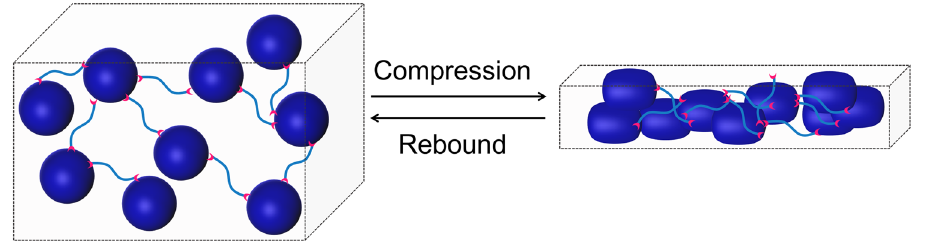
Figure 8. A macroporous cross-linked nanoelastomer-linear polymer network is attributed to the superelasticity and super resilience of dendrimer cryogels prepared via the cryo-aza-Michael addition of hyperbranched polyamidoamine dendrimer and linear